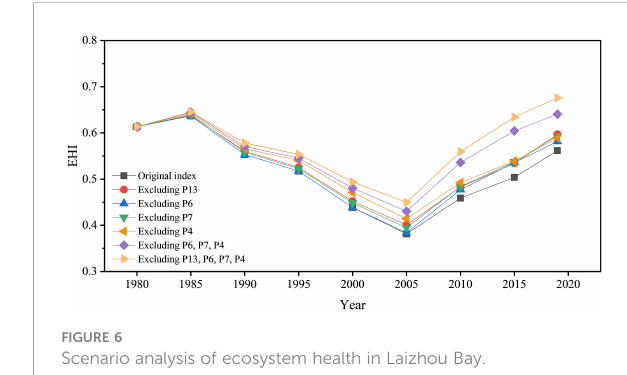
FIGURE 6 Scenario analysis of ecosystem health in Laizhou